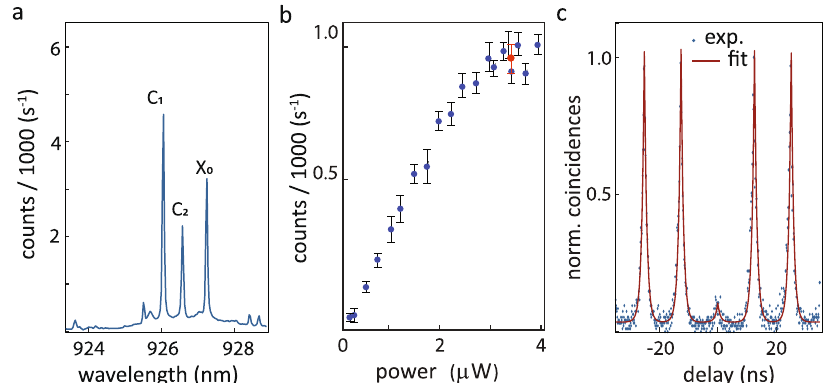
Fig. 3 | Single photon emission measured via ultra low-loss waveguide. a Quantum dot photoluminescence (PL) spectrum from a hybrid device pumped non-resonantly at 841.5nm, showing three transitions from the same QD. b PL intensityforX 0 asafunctionofinputpower.Reddot:pumplevelformeasurements in c . The uncertainties represent 95% con fi dence intervals computed from a